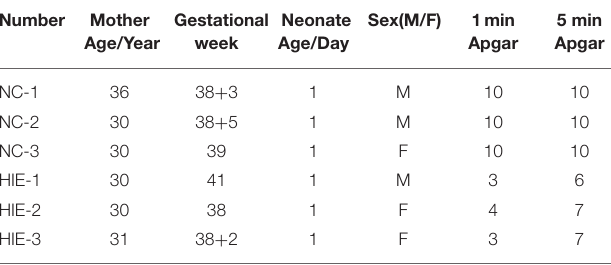
TABLE 1 | Clinical features of HIE and control